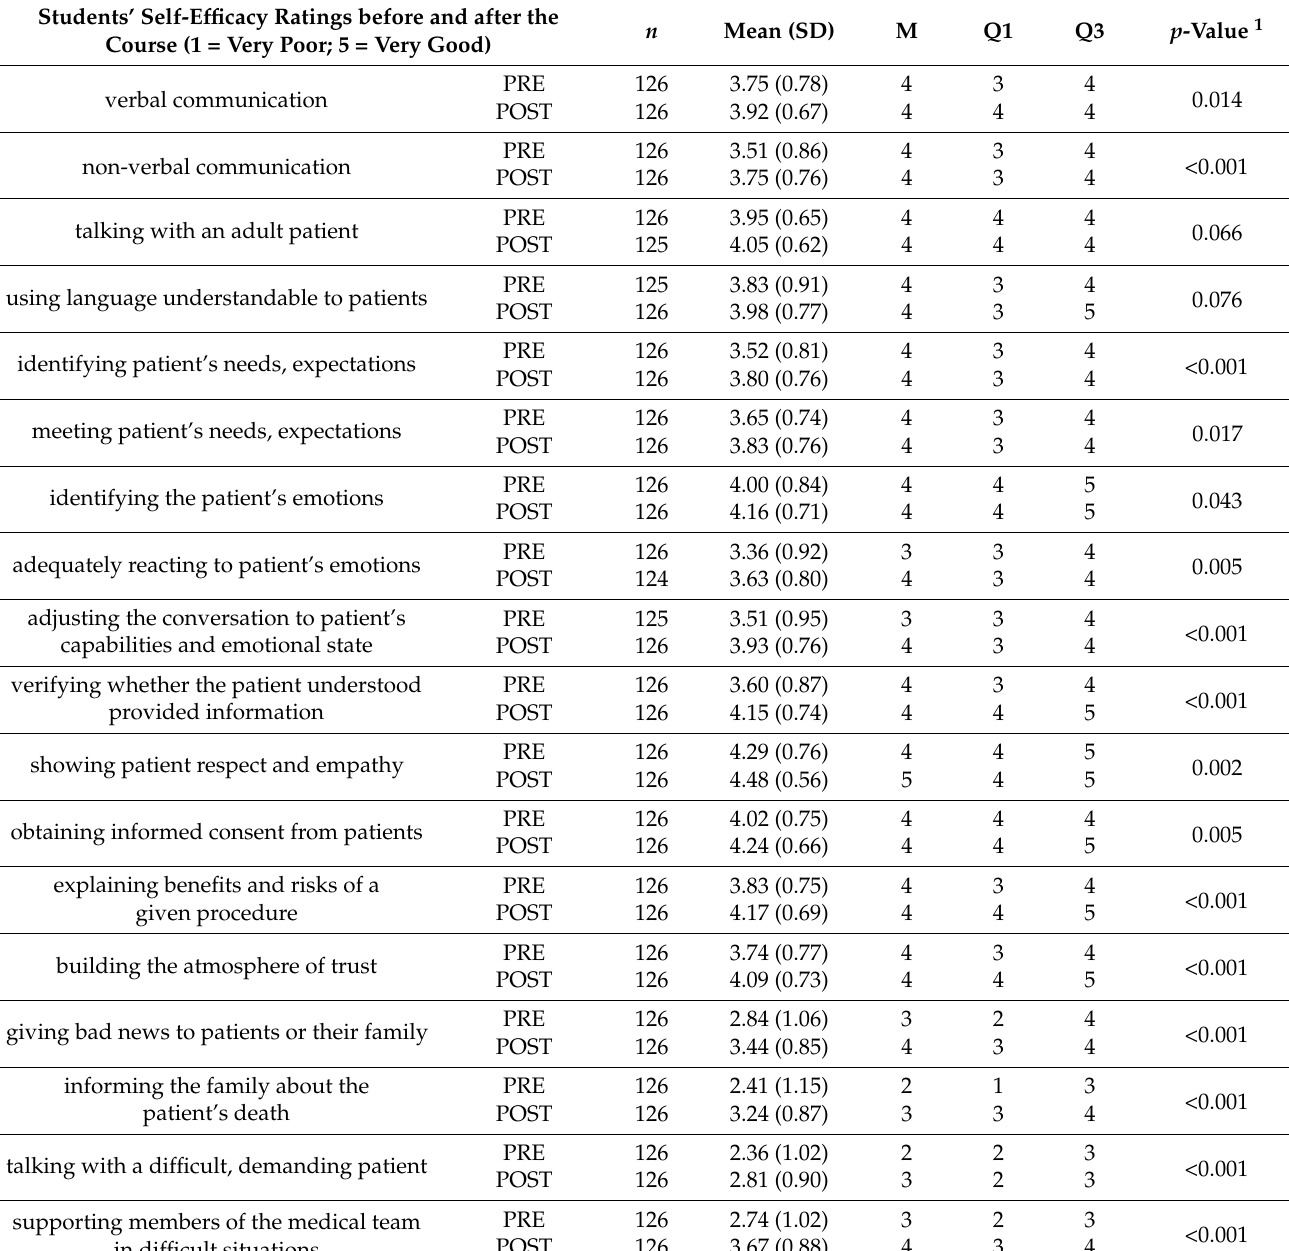
Table 2. The comparison of students’ self-efficacy ratings before and after the